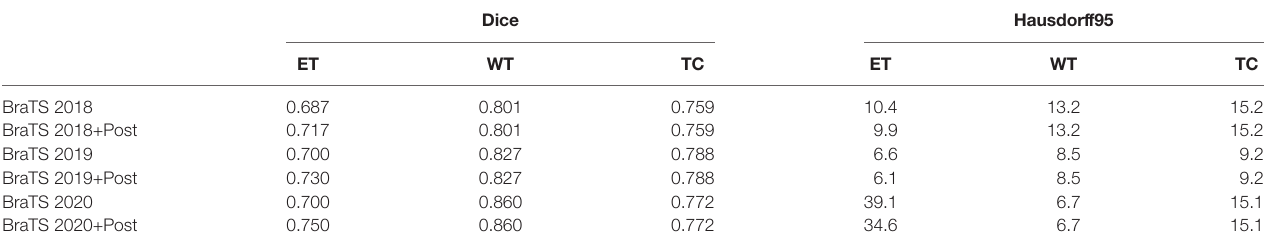
TABLE 1 | Comparison of Dice and Hausdorff95 post-processing of three validation sets.